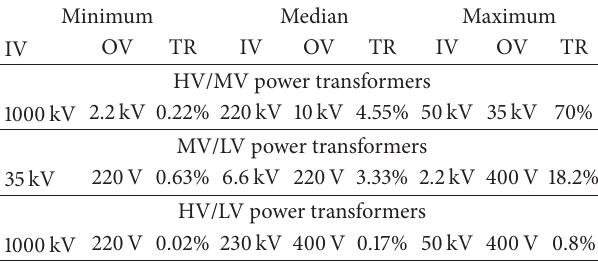
Table 5: Minimum, median, and maximum TR of HV/MV, MV/LV, and HV/LV power